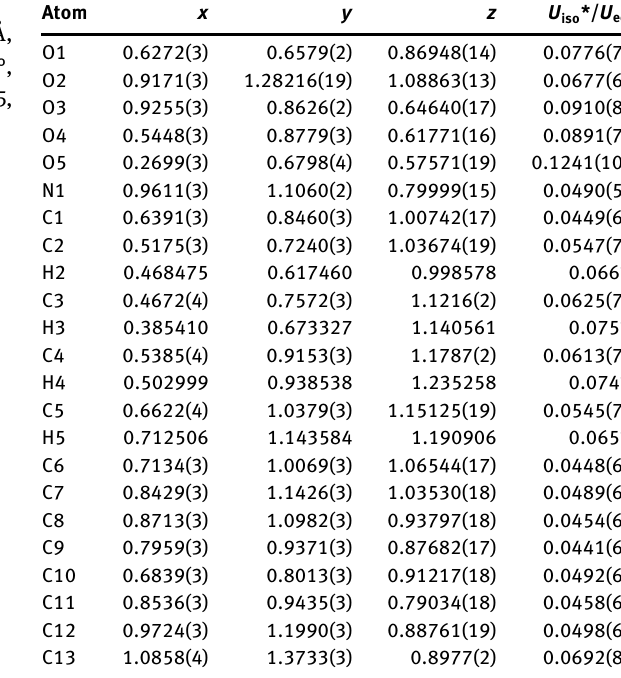
Table 2: Fractional atomic coordinates and isotropic or